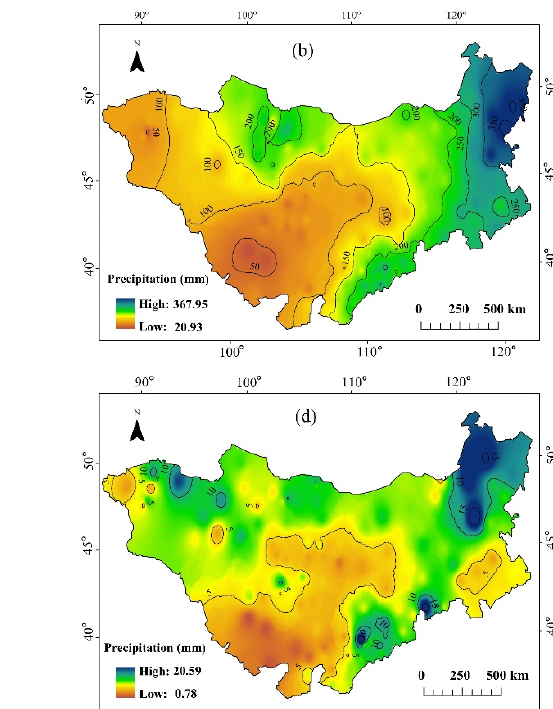
golian Plateau (( a ) Spring, ( b ) Summer, ( c ) Autumn, ( d ) Winter). lian Plateau (( a ) Spring, ( b ) Summer, ( c ) Autumn, ( d ) Winter).